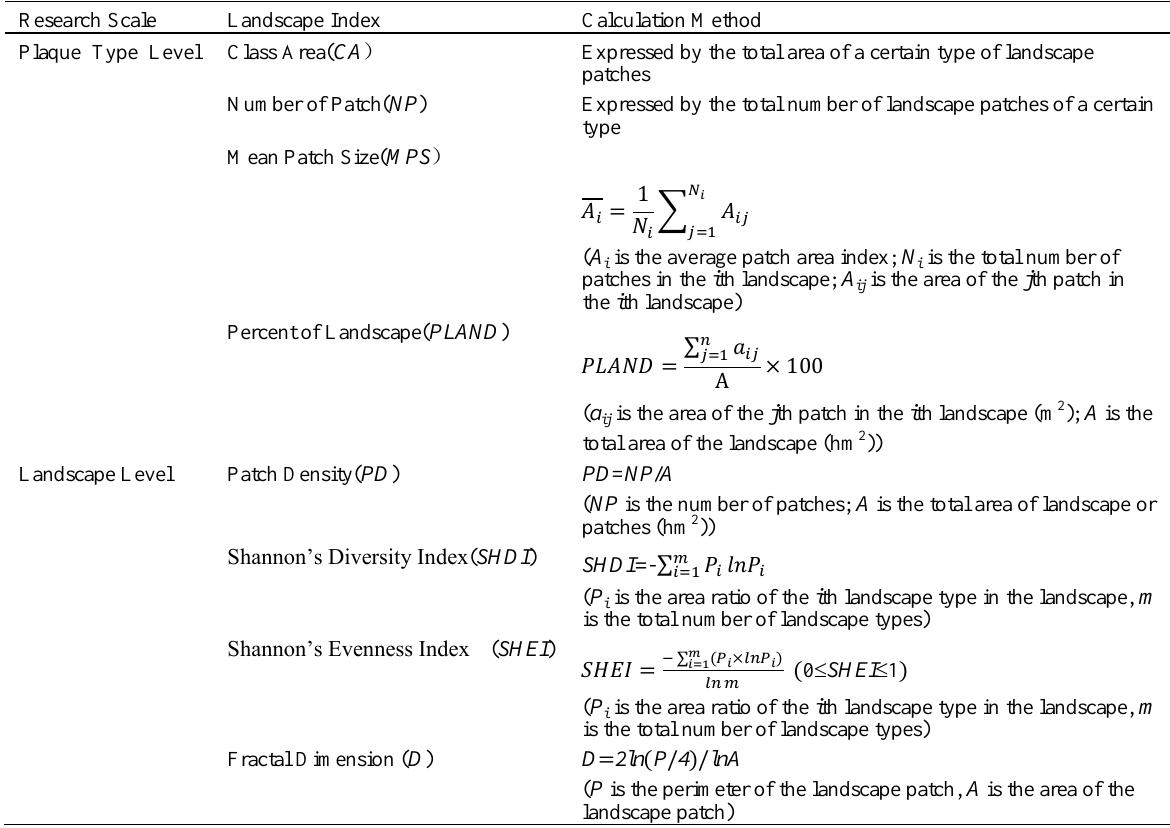
Table 1 . Selection of landscape pattern